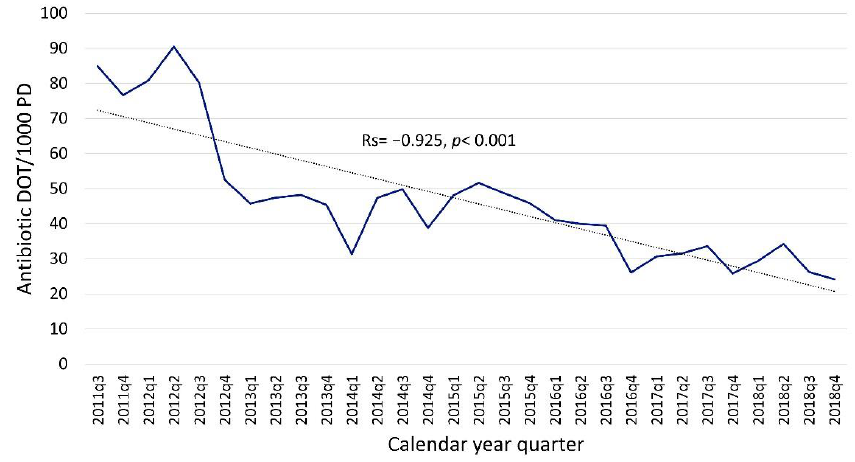
Figure 2. Quarterly broad-spectrum antibiotic utilization (meropenem, cefepime, piperacillin/tazobactam). These agents were monitored via PAF starting in 2013. Spearman’s correlation (Rs) assessed trends over time. DOT, days of therapy; PD, patient days.